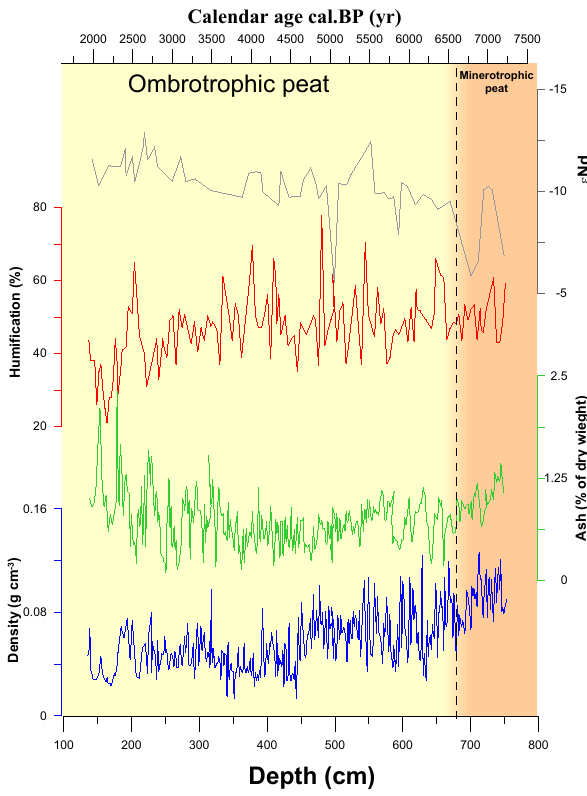
Fig. 3. Profiles of bulk density (gcm − 3 ) , ash content (%), humi- fication (%) and ε Nd. Light-brown areas correspond to the om- brotrophic peatland, and dark-brown bar to minerotrophic peat as defined by using Ca/Mg ratios, Sr concentration and testate amoe- bae assemblages.